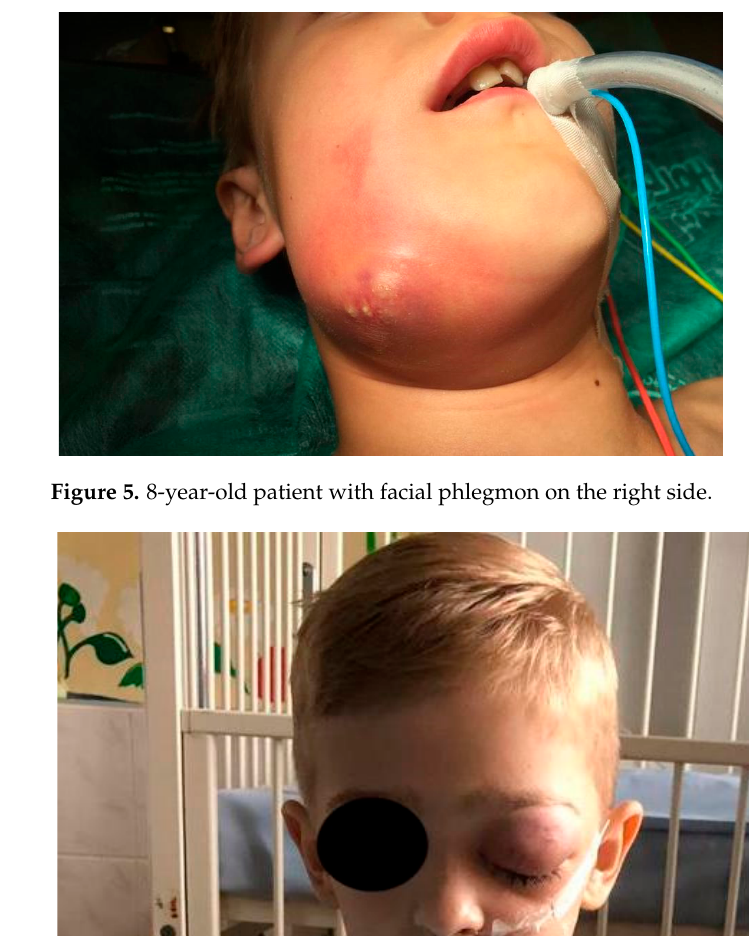
Figure 7. Odontogenic source of infection of the maxilla.